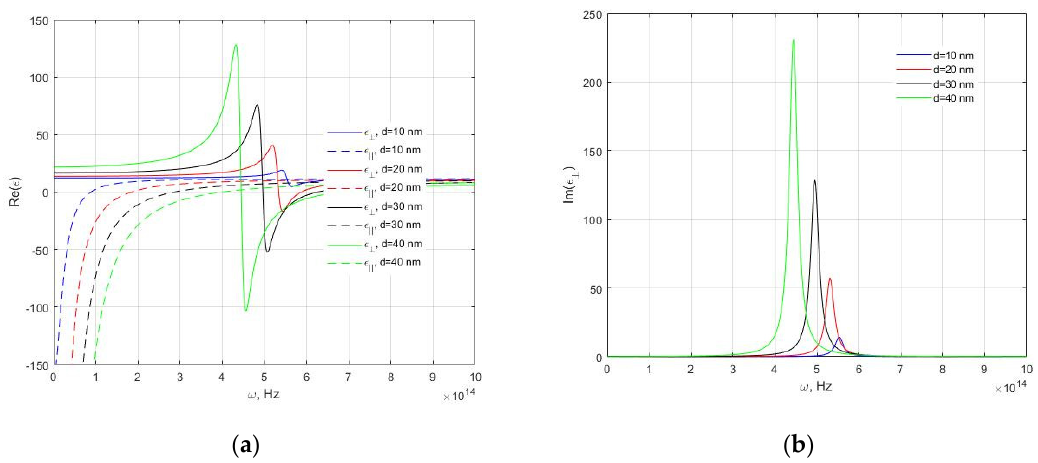
Figure 2. ( a ) Dependences of the real parts of the perpendicular and parallel permittivity components, upon frequency of the silver nanowire metamaterial. ( b ) Dependence of the imaginary part of the perpendicular permittivity component upon frequency. S = 70 nm.